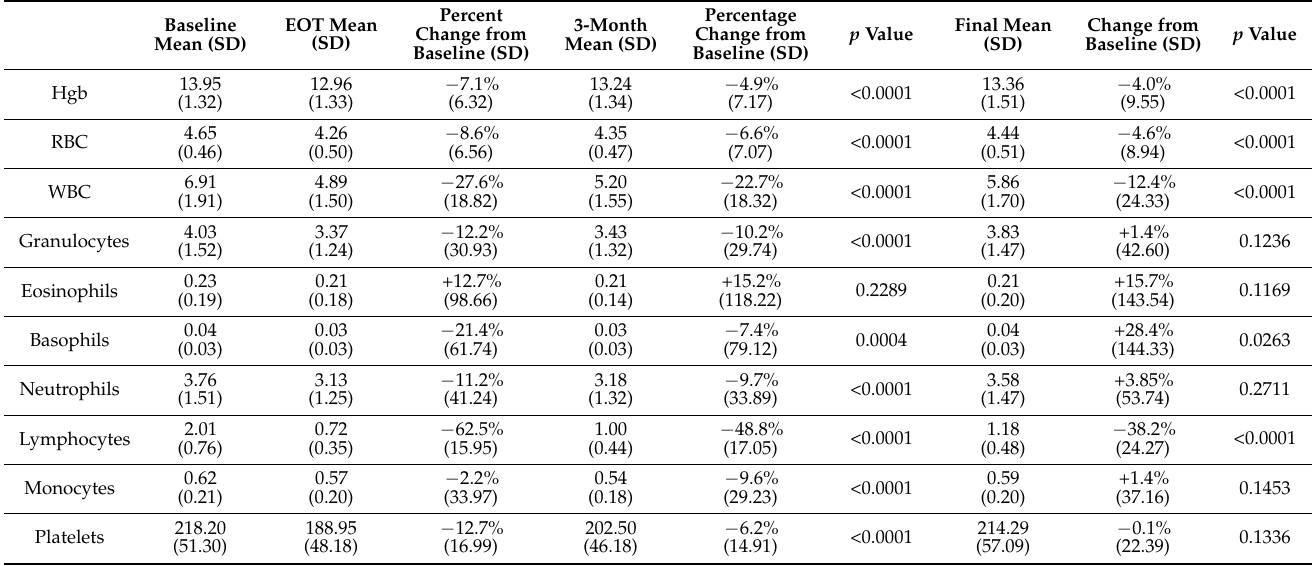
Table 1. Entire cohort ( n = 301) effect on blood counts from baseline to end of treatment, 3-month follow-up and longer-term (“final”) follow-up (mean 28 months).